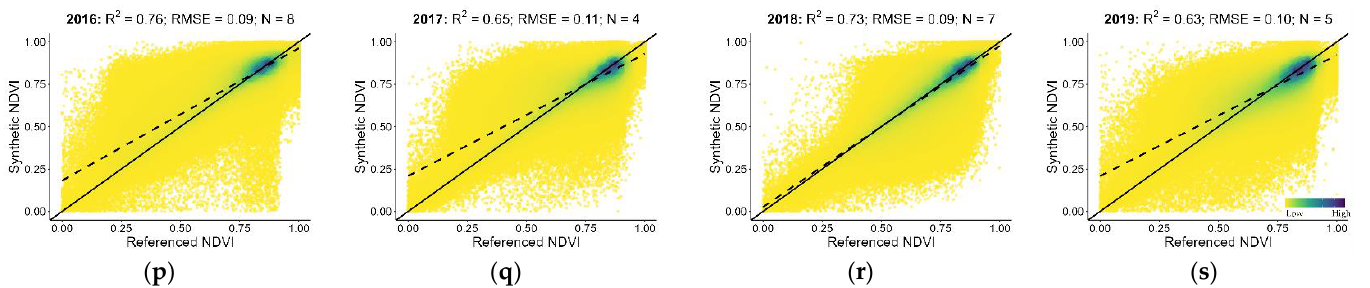
Figure 3. The scatter plots ( a – s ) compare the accuracies of Landsat (referenced NDVI) with L-MOD13Q1 (synthetic NDVI) for 2001 to 2019. The values of the statistical parameters such as R 2 and RMSE and the total number of Landsat scenes available every year (N) are displayed at the top of each plot. Every plot contains a solid line (1:1 line) that is used to visualise the correlation of pixels between the referenced and synthetic NDVI values. The dashed line represents the regression line. The colour of scatter plots depicts the density of points (yellow: low, blue: high).